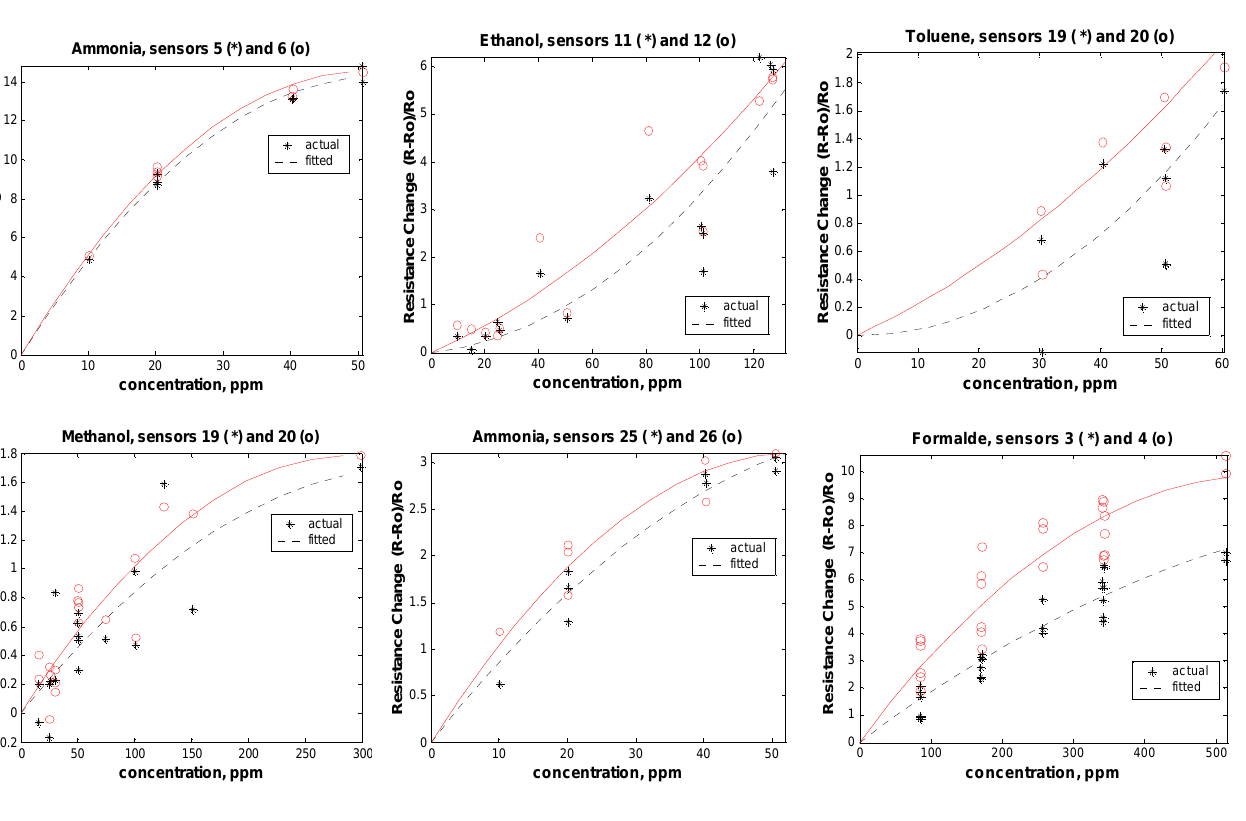
Figure 2. Low order non-linearity is observed in responses of some sensors. The lines passing through the stars are the least-squares fitted responses, while the actual data points are shown by open circles. The LM-NLS method demonstrated rapid operation speed and low memory requirements in addition to relative ease of training. Currently it takes 1-5 minutes to analyze each event on a non- dedicated Pentium III PC with MATLAB 5.3. That is quick enough to be used for “quasi real time” air monitoring. The computation time can be further reduced when optimized for real time code. The convergence problem can be improved by using multiple starting points as well as a modified update strategy (see Section 3, below) and is also relaxed by the fact that the quantification accuracy requirement in our case is rather